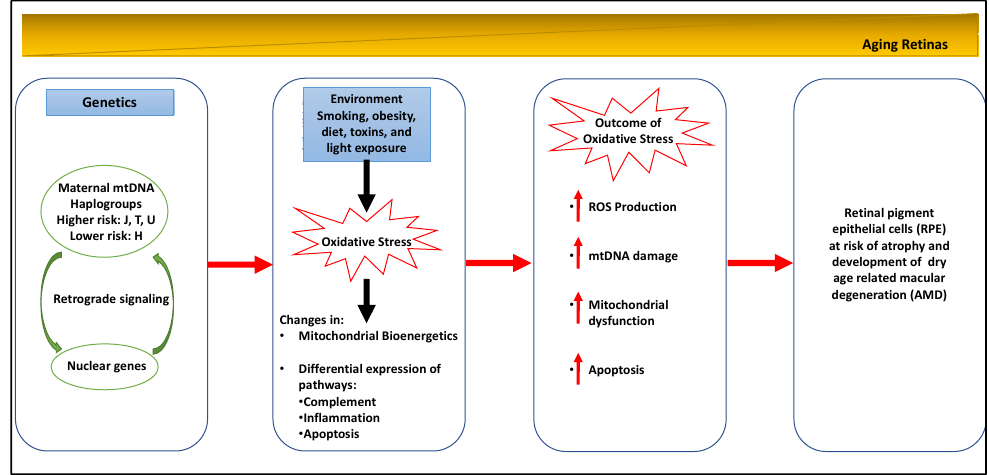
Figure 3. Mitochondrial involvement in dry age-related macular degeneration (AMD).